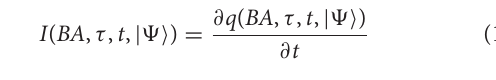
PST e-Prime 2.0.8.90 tool 2